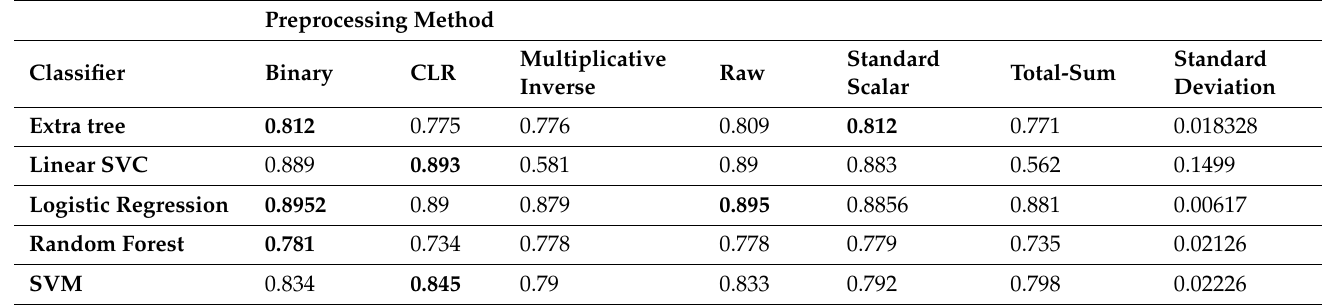
Table 2. Performance of the top 5 models for city classification: The accuracy and standard deviation between the model accuracy for the 5 five